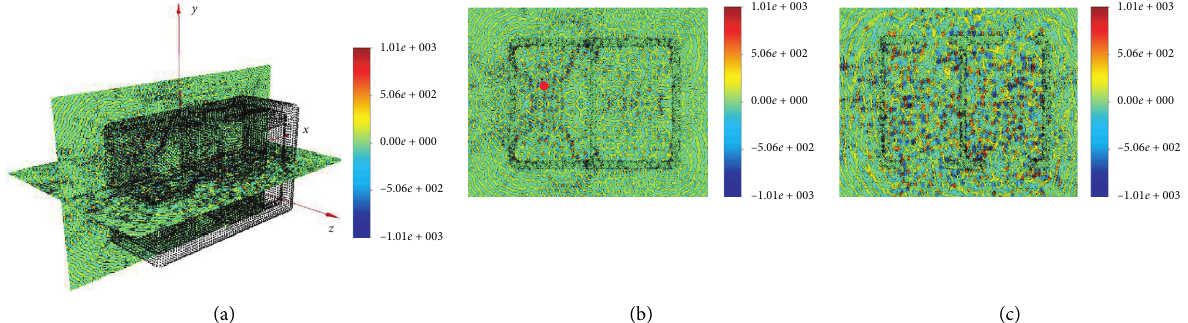
Figure 11: The isometric (a), x - y plane (b), and x - z plane (c) view of the rooms for the source location ( − 0.6m, 0m, − 0.8m).